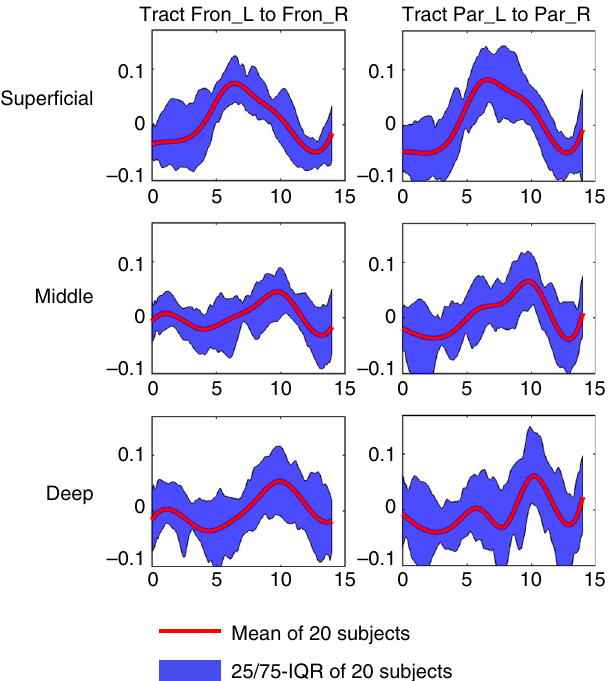
Fig. 7 Average time courses in different depths of the WM tract. The x -axis is the time (seconds), y -axis is the signal intensity (a.u.). Time = 0 is aligned to the onset of each incongruent stimulus. IQR = Interquartile Range. Source data are provided as a Source Data fi